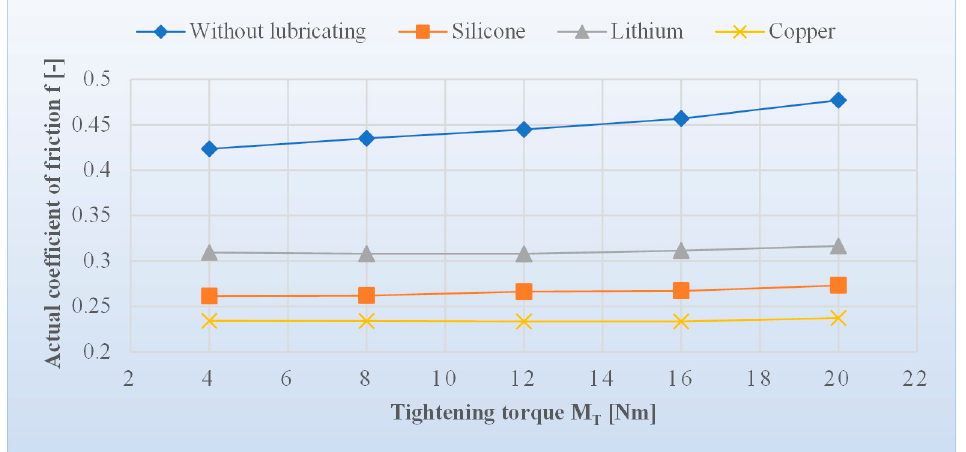
Figure 13. Dependence of the tightening torques on the actual calculated coefficients of friction with and without lubricating grease.